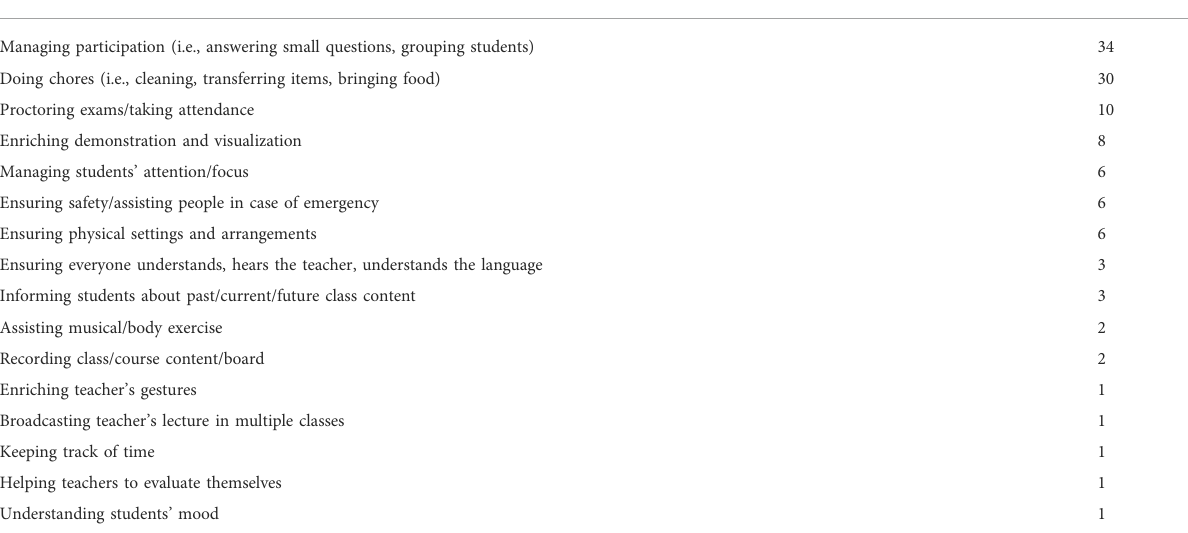
TABLE 3 Coding scheme used for the desired tasks for the social drone in classroom.